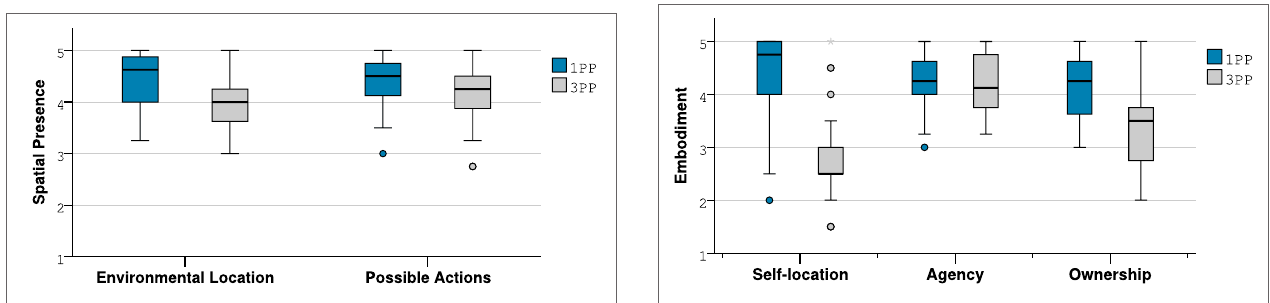
FigUre 8 | Boxplot of the averages of the SL, A and O factors of the embodiment dimension.